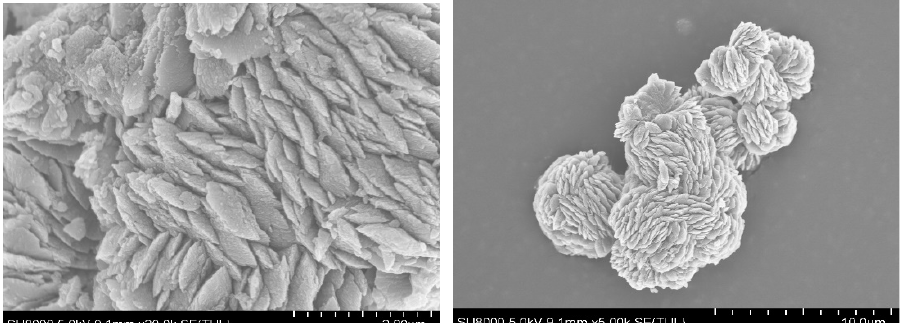
Table 2. Hydrogen bond geometry (Å, o ) for [ Cu 2 (EDPB)•H 2 O] n . D-H…A D-H H...A D...A D-H…A N2–H2…O2 i